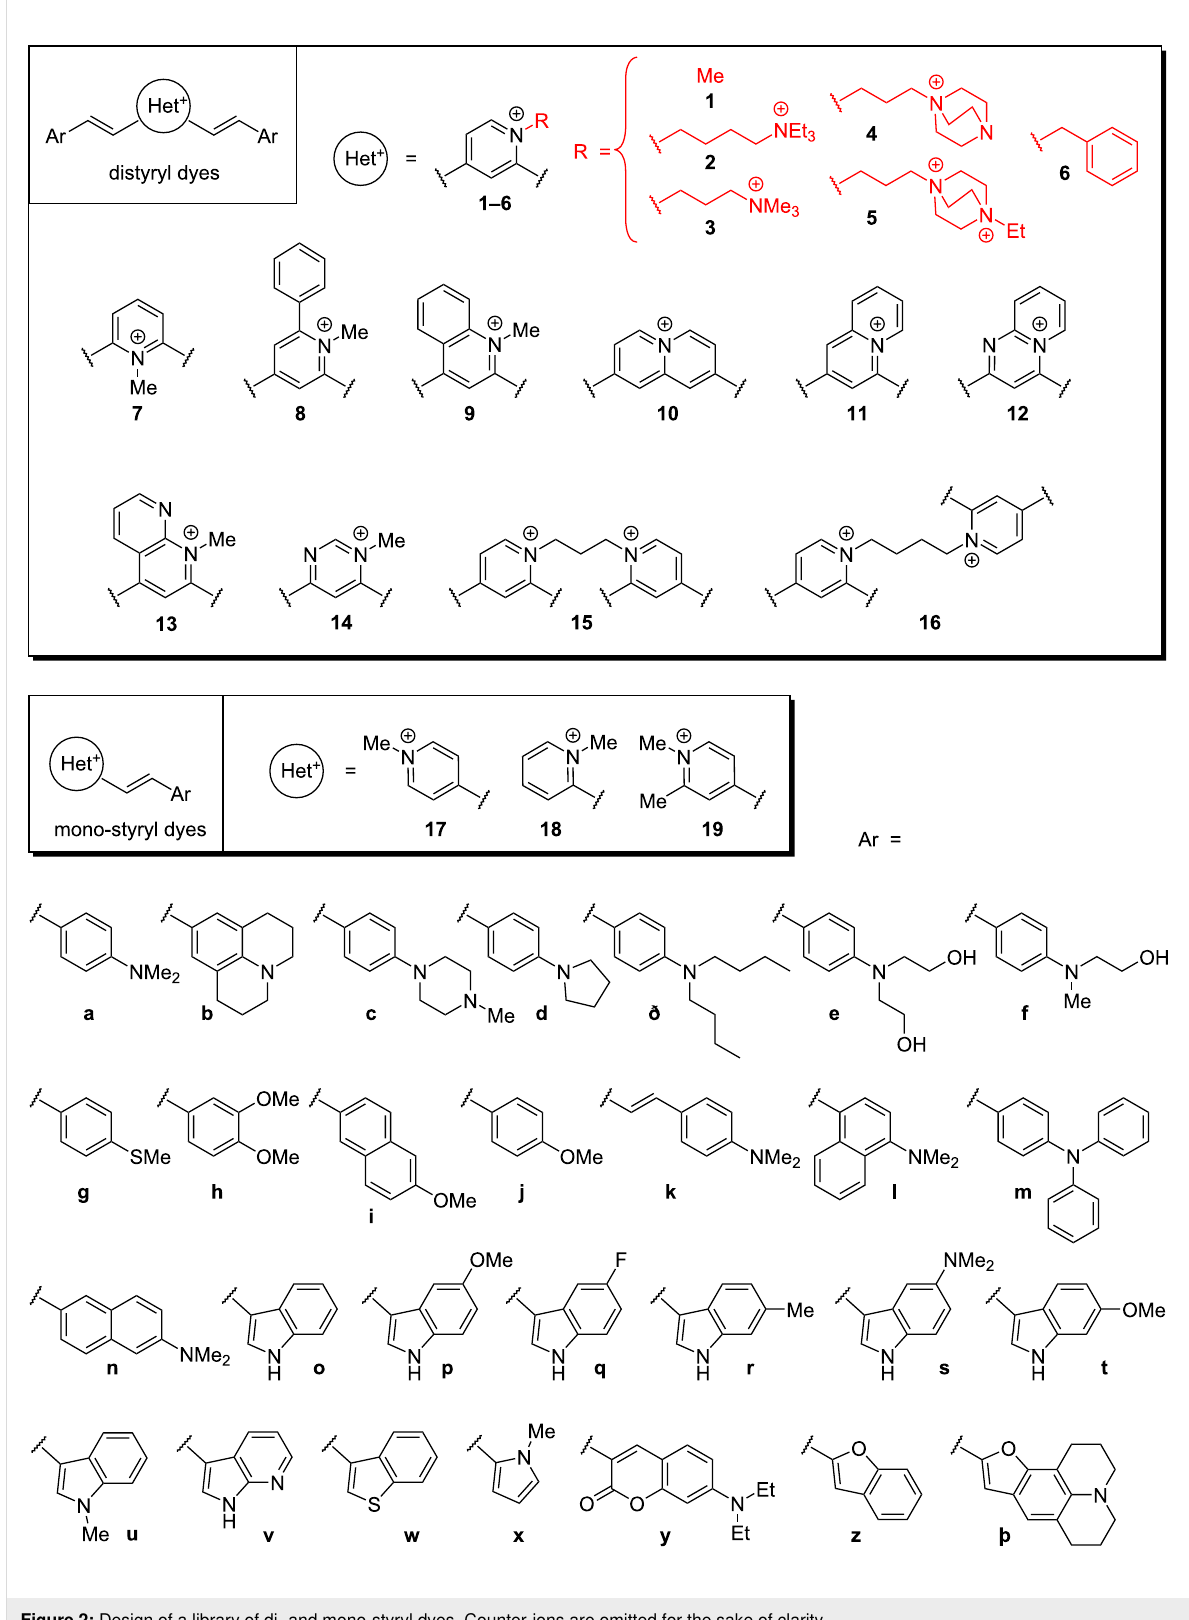
Figure 2: Design of a library of di- and mono-styryl dyes. Counter-ions are omitted for the sake of